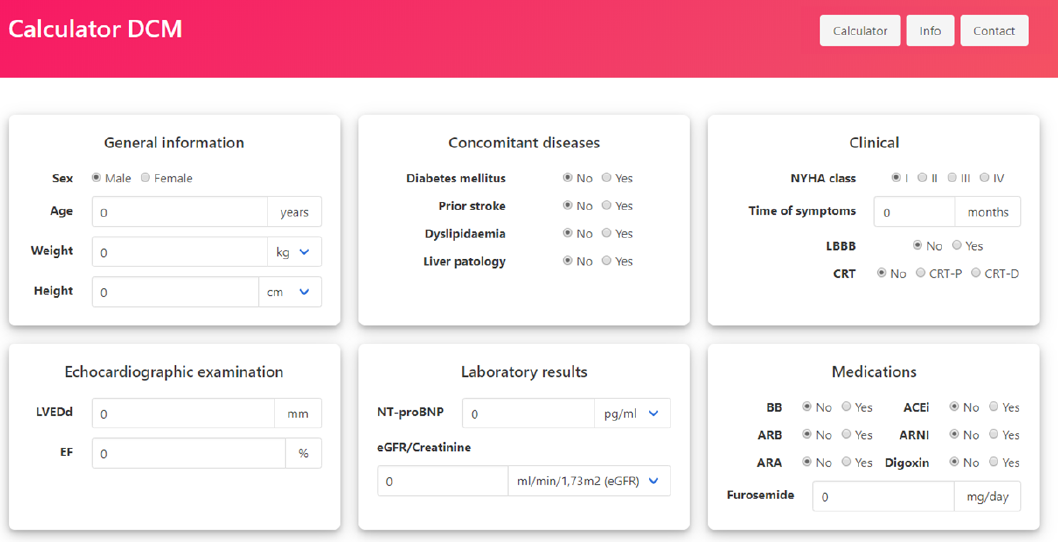
Figure 3. Online tool for the calculation of individual mortality risk based on the Krakow DCM Risk Score (available on the Heart Failure Association of the Polish Cardiac Society official webpage: https://www.niewydolnosc-serca.pl/kalkulator.html; accessed 07.02.2022).